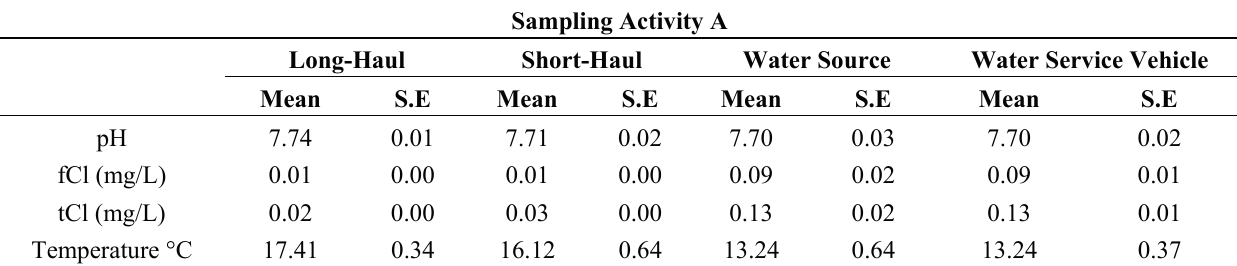
Table 4. Physical and Chemical Analysis for Sampling Activity A across Long- and Short-haul Aircraft, the Water Source and the Water Service Vehicle. Sampling Activity A Long-Haul Short-Haul Water Source Water Service Vehicle Mean S.E Mean